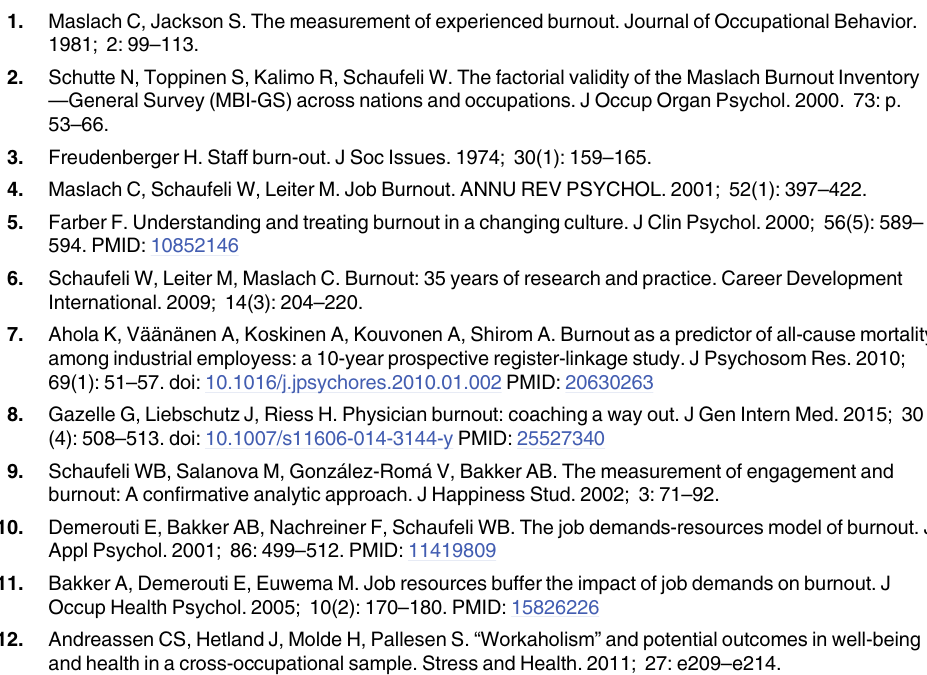
S1 Fig. “ Burnout Clinical Subtype Questionnaire ” (BCSQ-36). S2 Fig. Fix indices for the CFA of the BCSQ-36 and models of